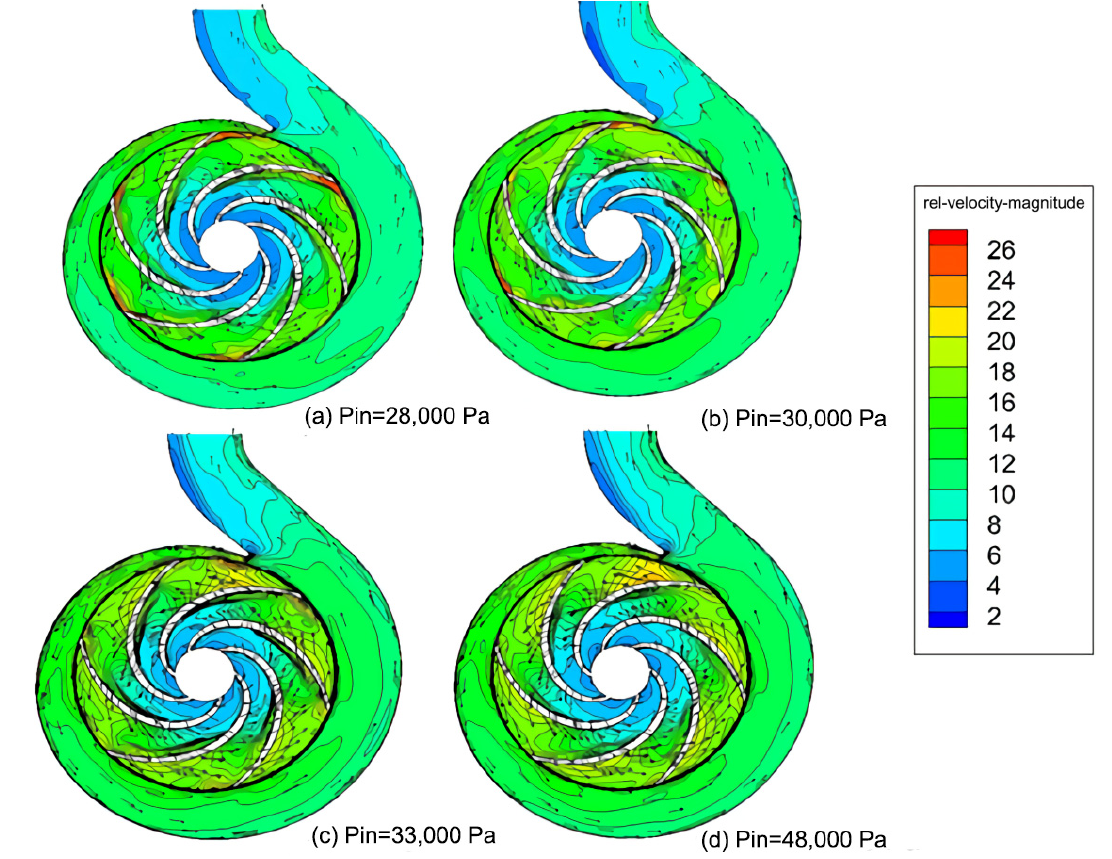
Figure 7. Relative velocity distribution at different NPSHs.